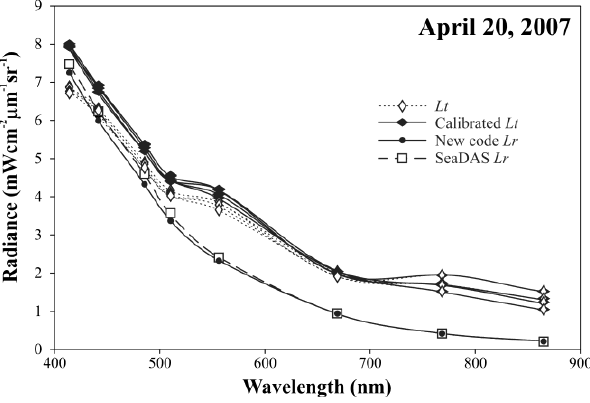
Figure 9. Comparison of TOA radiance before vicarious calibration ( L calibration (Calibrated L ) at four selected sites (S1, S7, S9 and S12) from the 12 sites in t Lac des Allemands for the OCM data of 20 April 2007. Comparison of Rayleigh path radiance ( L ) calculated by the new code and SeaDAS at these 4 sites is also shown. r